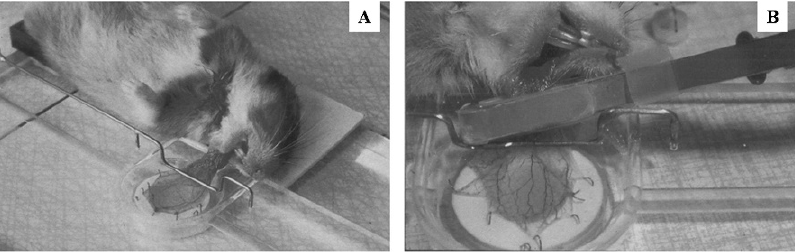
Figure 2 - A. Hamster cheek pouch (HCP) model. B. The inflatable cuff mounted around the neck of the prepared cheek pouch